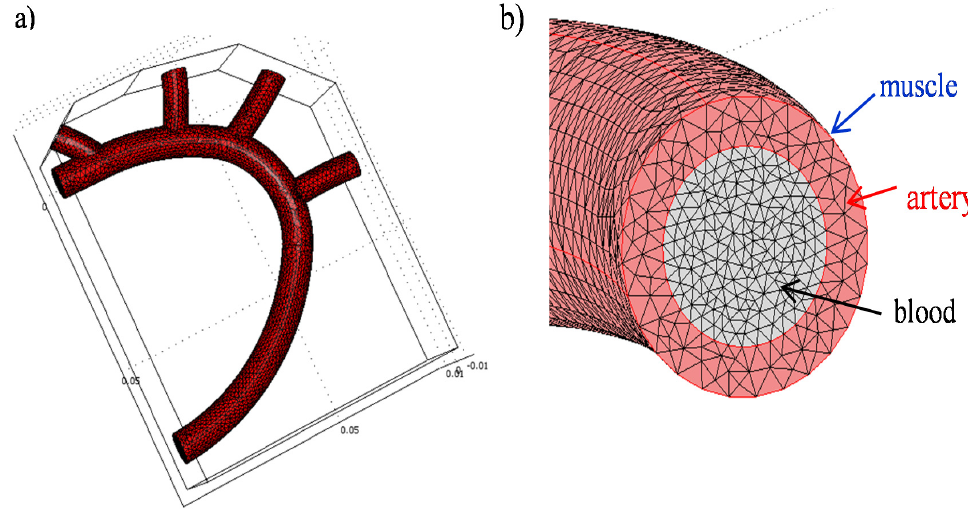
Figure 3. ( a ) Geometry mesh, ( b ) zoom of the mesh of the inlet/outlet surface.